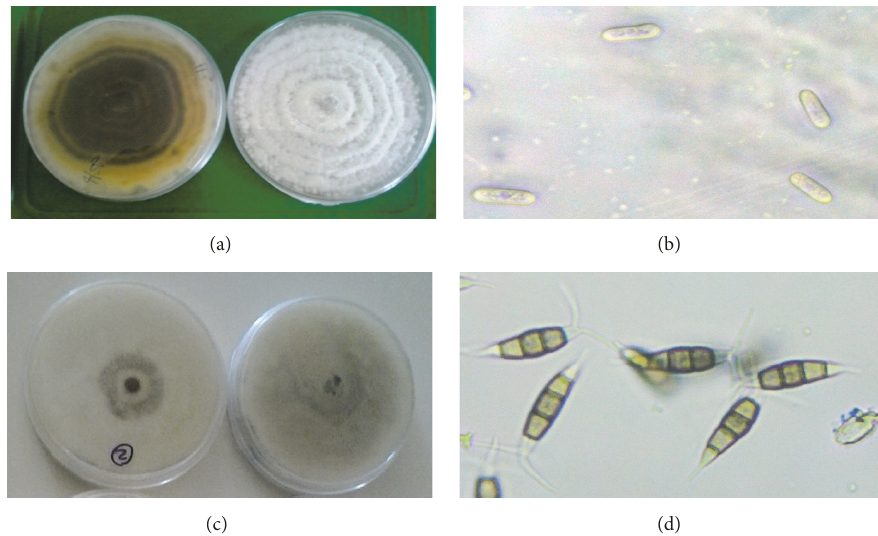
Figure 2: Mycelia of Colletotrichum gloeosporioides (a) and Colletotrichum gloeosporioides spores (b) ( × 400) and mycelia of Pestalotiopsis microspora (c) and Pestalotiopsis microspora spores (d) ( ×